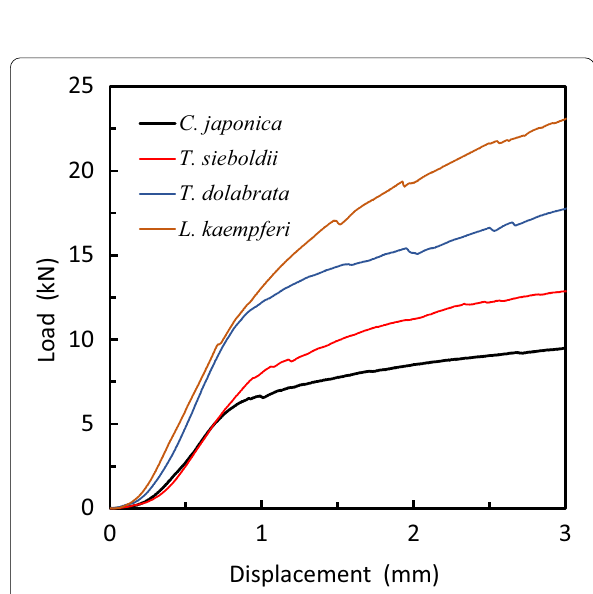
Fig. 5 Relationship between load and displacement obtained by embedment test